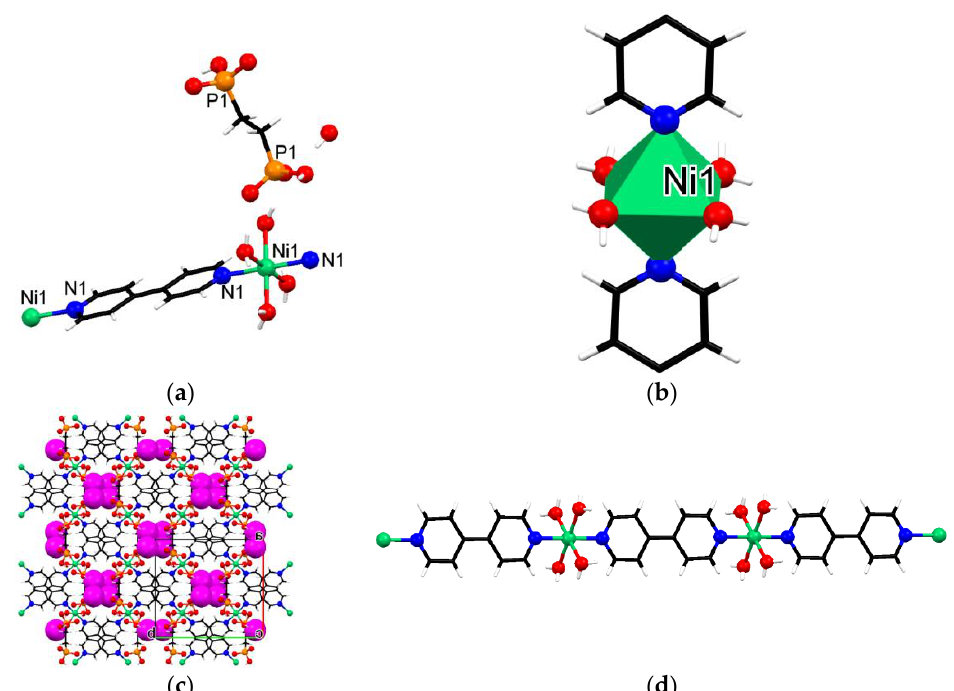
Figure 6. Crystal structure of Ni- 4,4’ -bpy-EDPA : ( a ) View of the cation-anion pair; ( b ) The [Ni (H 2 O) 4 ( 4,4’ -bpy )] 2+ polyhedron; ( c ) Packing along the c axis. Lattice waters are shown as magenta spheres; ( d ) Portion of the 1D “Ni (H 2 O) 4 - 4,4’ - bpy” chain.